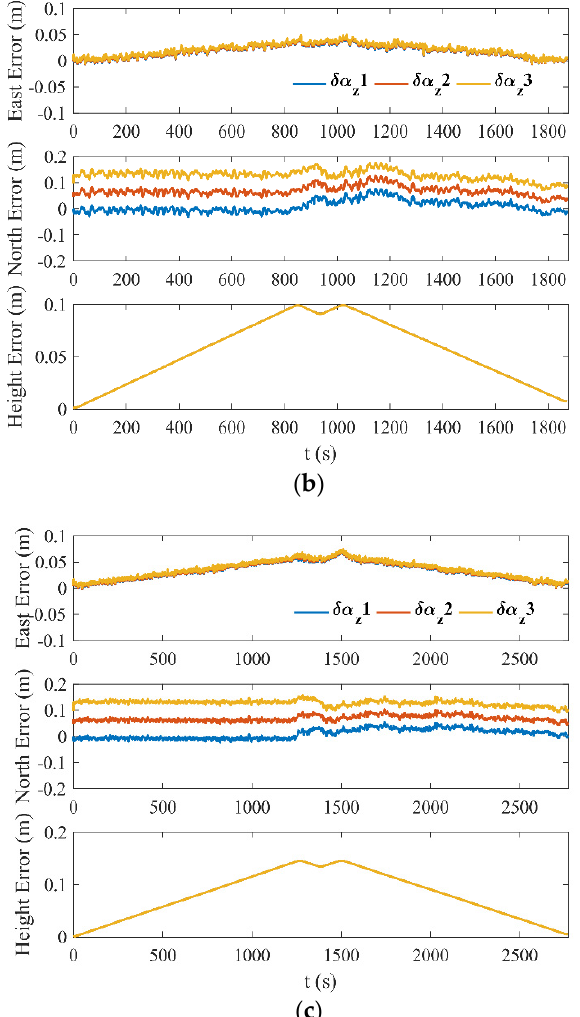
Figure 8. Positioning errors under different simulation trajectories: ( a ) positioning errors of 50 m trajectory; ( b ) positioning errors of 100 m trajectory; ( c ) positioning errors of 150 m trajectory.